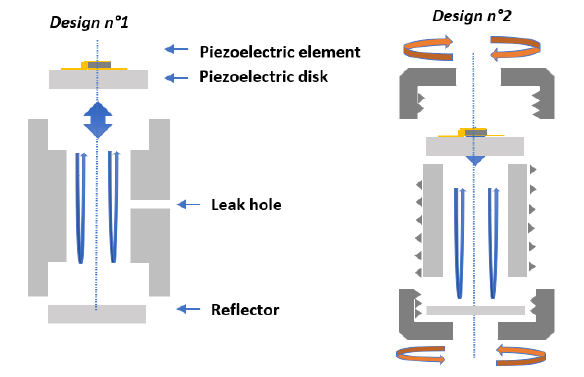
Figure 2 : (left) first design of the acoustic device (right) second design of the acoustic